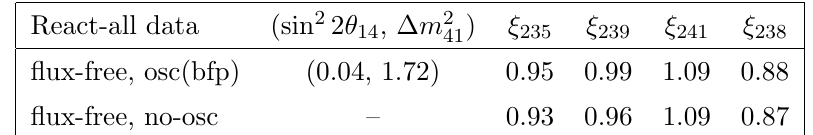
Table 4 . Values of the (cid:12)ssion fraction pull parameters for the (cid:13)ux free analysis at the oscillation best (cid:12)t point and without oscillation. These factors measure the relative rescaling of the IBD yields of each isotope with respect to the theoretical predictions, cf. eq. (2.1).